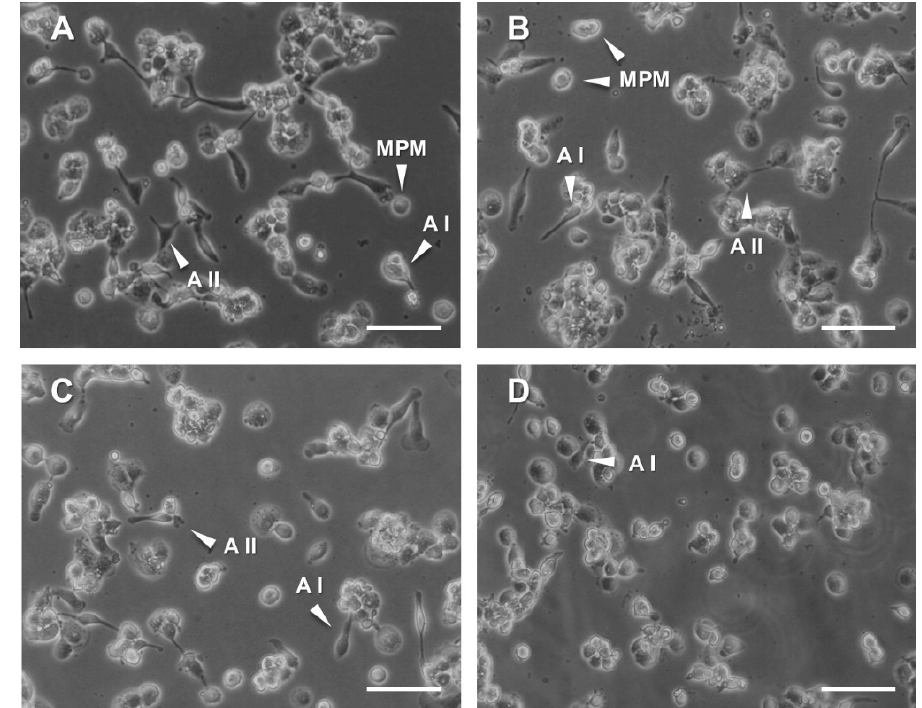
Figure 5. Morphological analysis of THP-1 cells grown in the presence of the material powders or genipin and treated with 100 nM PMA for 48 h. ( A ) Positive control of THP-1 cells treated by the only PMA inflammatory stimulus. ( B ) PMA-treated cells + CS powder (0.15 mg / mL). ( C ) PMA-treated cells + GN1p (0.15 mg / mL); the representative picture is comparable to data not shown for the GNp and GN2p treatments. ( D ) PMA-treated cells + gn (0.022 µ g / mL). MPM: monocytes pre-macrophage cells; AI: adhered stage I, cells showing low morphological complexity, with n = 1 pseudopodial elongation; AII: adhered stage II, adhered cells with n ≥ 2 pseudopodial elongations and advanced morphological complexity (Bright field images, 10× magnification, scale bar: 50 µm).